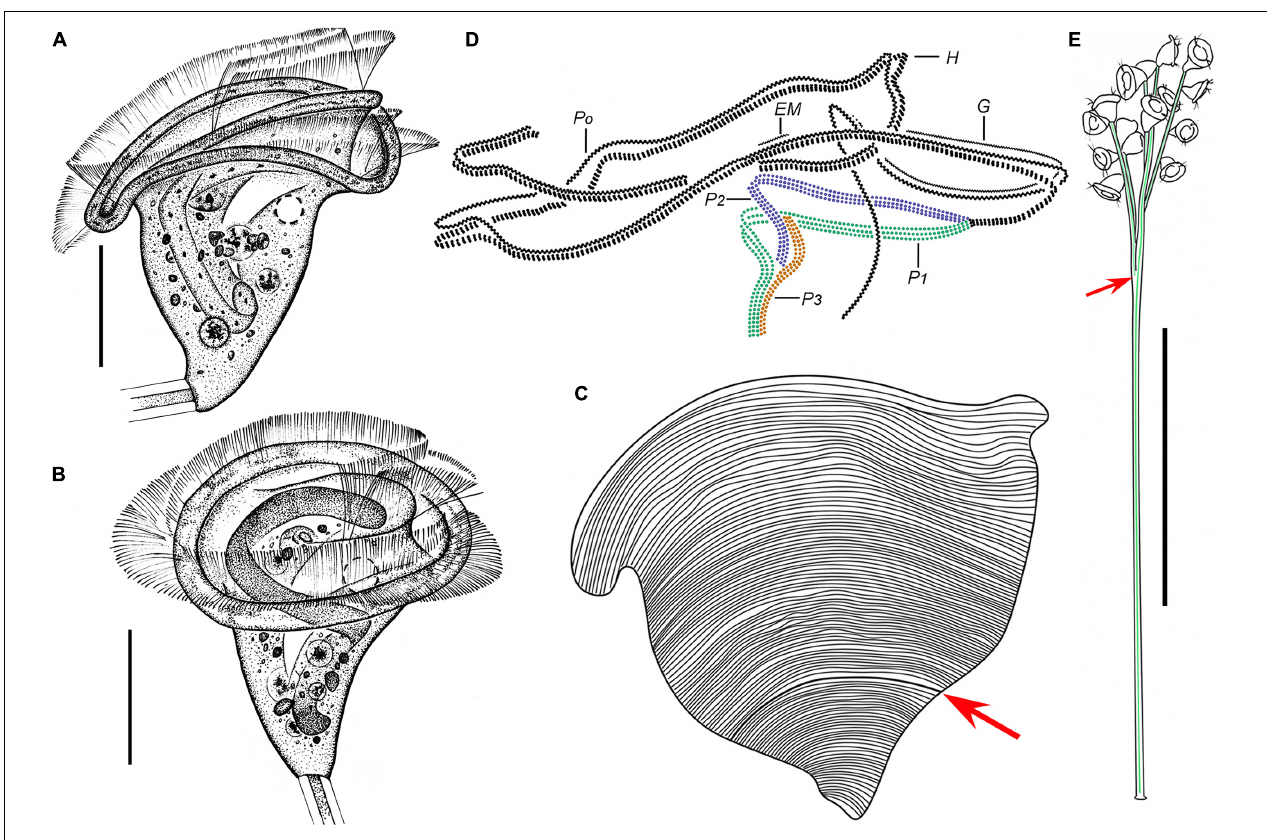
FIGURE 10 | Carchesium polypinum in vivo (A–C,E) and after protargol staining (D) . (A,B) Different zooids showing the shape variation. (C) Pellicular striations; arrow marks the trochal band. (D) Oral ciliature. (E) A developing colony; arrows mark the discontinuous spasmoneme (in green). EM, epistomial membrane; G, germinal kinety; H, haplokinety; Po, polykinety; P1–3, infundibular polykineties 1–3. Bars: 25 µ m in panels (A,B) and 700 µ m in panel (E)